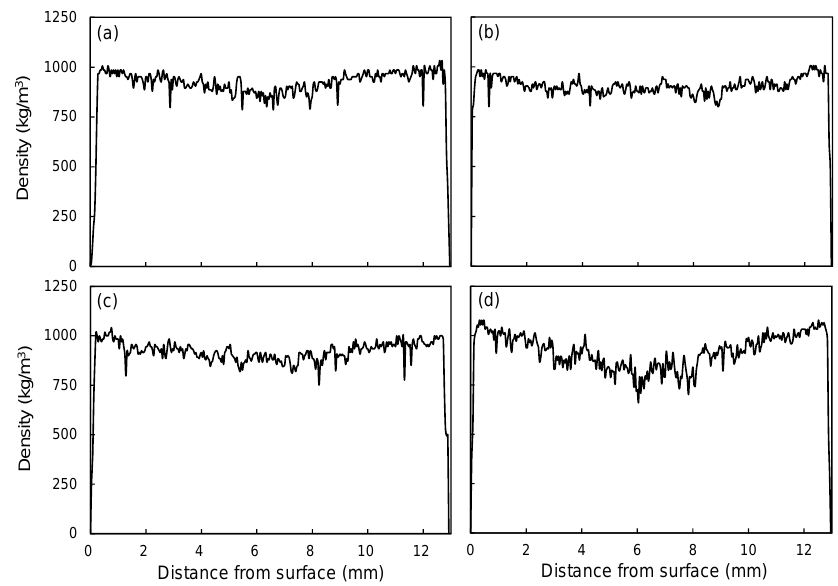
Figure 2. The vertical density profiles of WPCs made with makino bamboo ( a ); India-charcoal trema ( b ); Taiwan red pine ( c ); and Chinese fir ( d ).